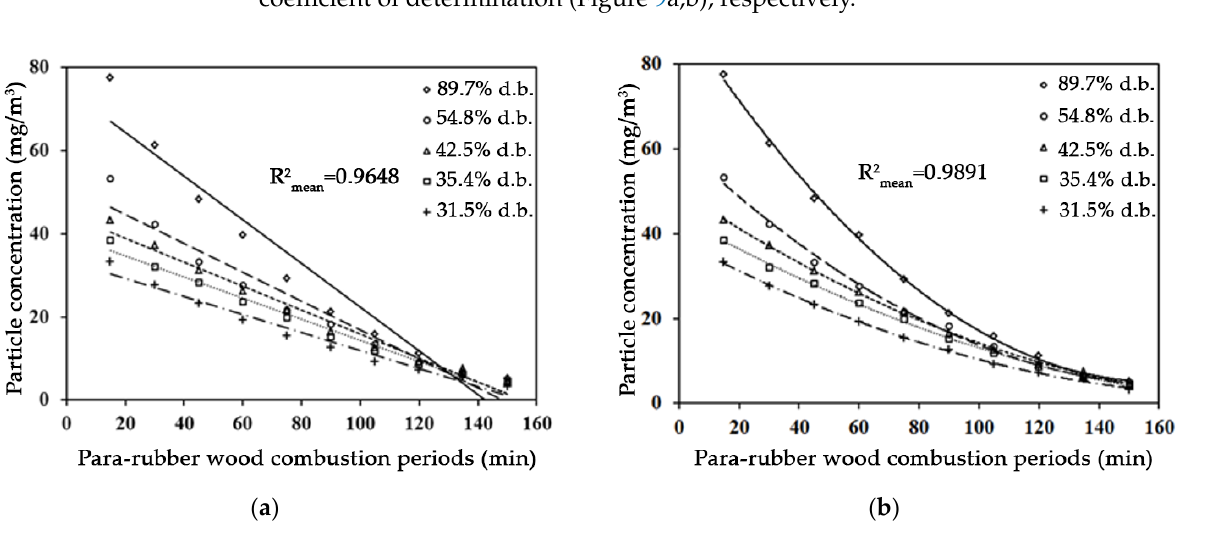
Figure 9. Comparison of predicted and experimental TPMC values: ( a ) First-degree model; ( b ) Second-degree model.